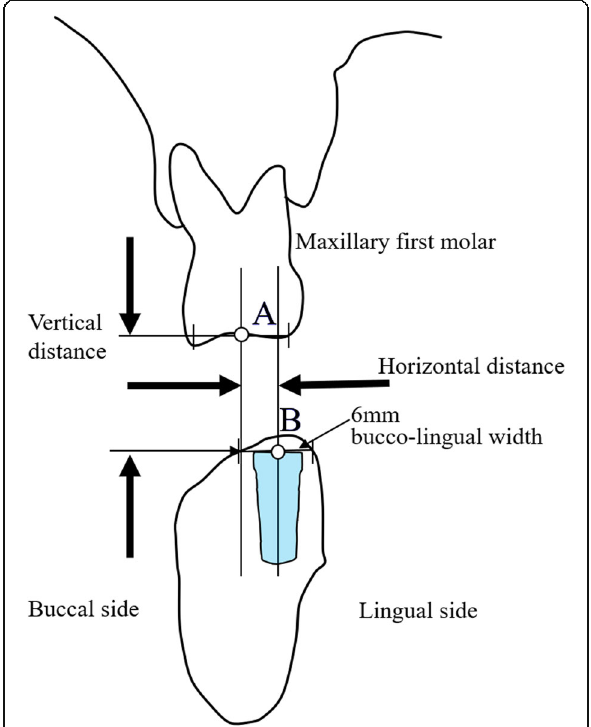
Fig. 1 Cross-sectional image perpendicular to the dental arch passing through the mesiodistal midpoint of the maxillary first molar: an implant in the mandible first molar region. A: reference point of the maxillary first molar: the buccopalatal midpoint of the occlusal surface of the maxillary first molar. B: reference point of the maxillary first molar: buccolingual midpoint of the occlusal side of the implant